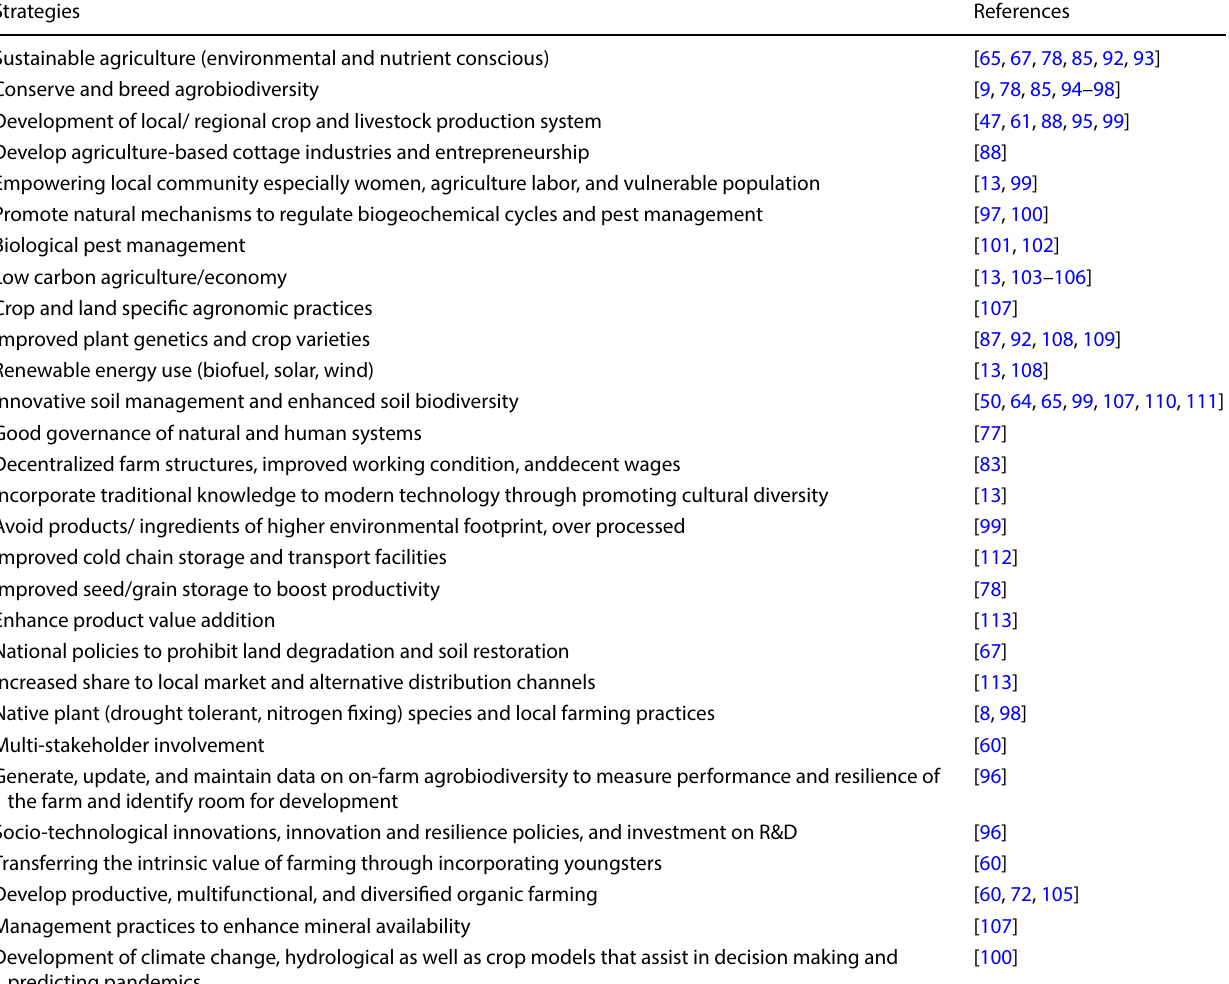
Table 2 Potential practices to enhance agro-ecosystem resilience to cater the diverse food demand and dietary requirement